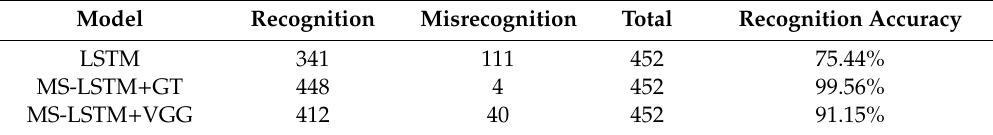
Table 9. Performances of the 3 networks only using fake conflict samples.